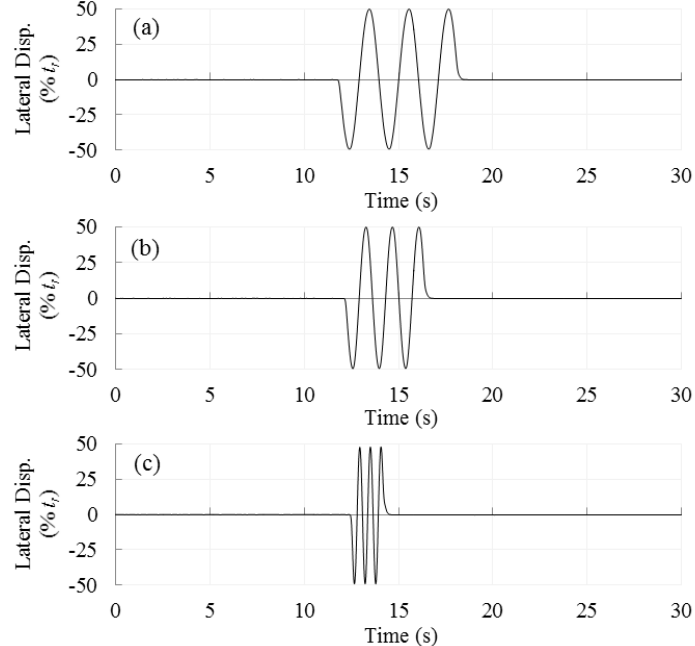
Figure 6. Lateral cyclic displacement (50% t r ) for three different rates; ( a ) 20 mm/s; ( b ) 30 mm/s; ( c ) 75 mm/s. ( c ) 75